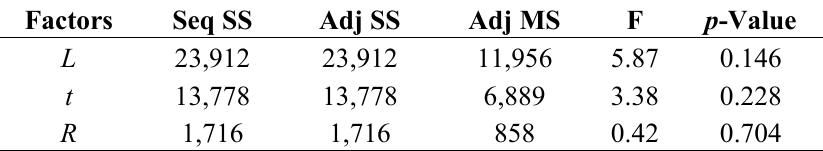
Table 6. Analysis of variance for collapse strength.